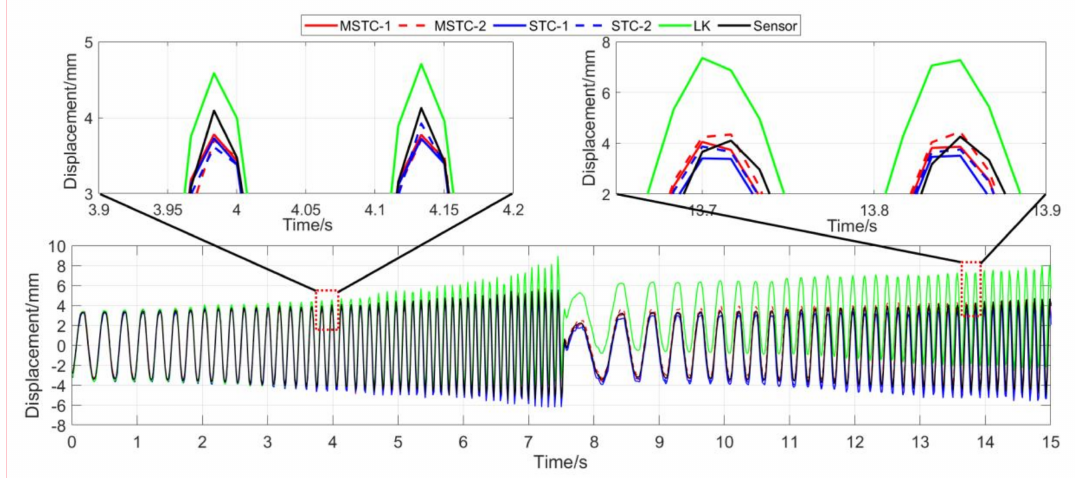
Figure 18. Displacement time history and local amplification in Scenario III (59.96 FPS).